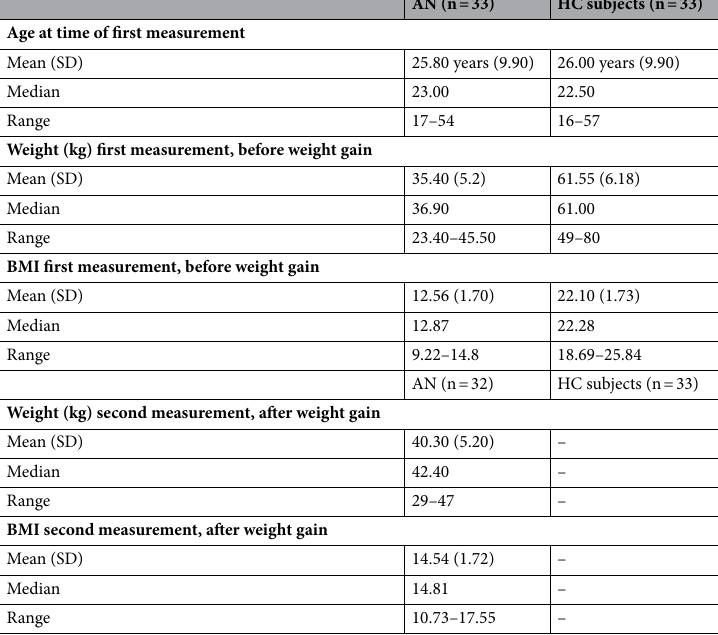
Table 1. Summarized metadata. AN patients with anorexia nervosa, HC healthy weight controls.